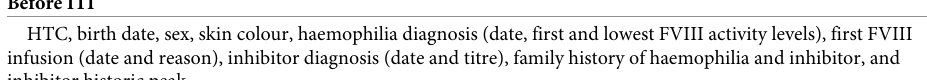
Table 1. Clinical and treatment data collected in the BrazIT Study, using a validated case report form. Before